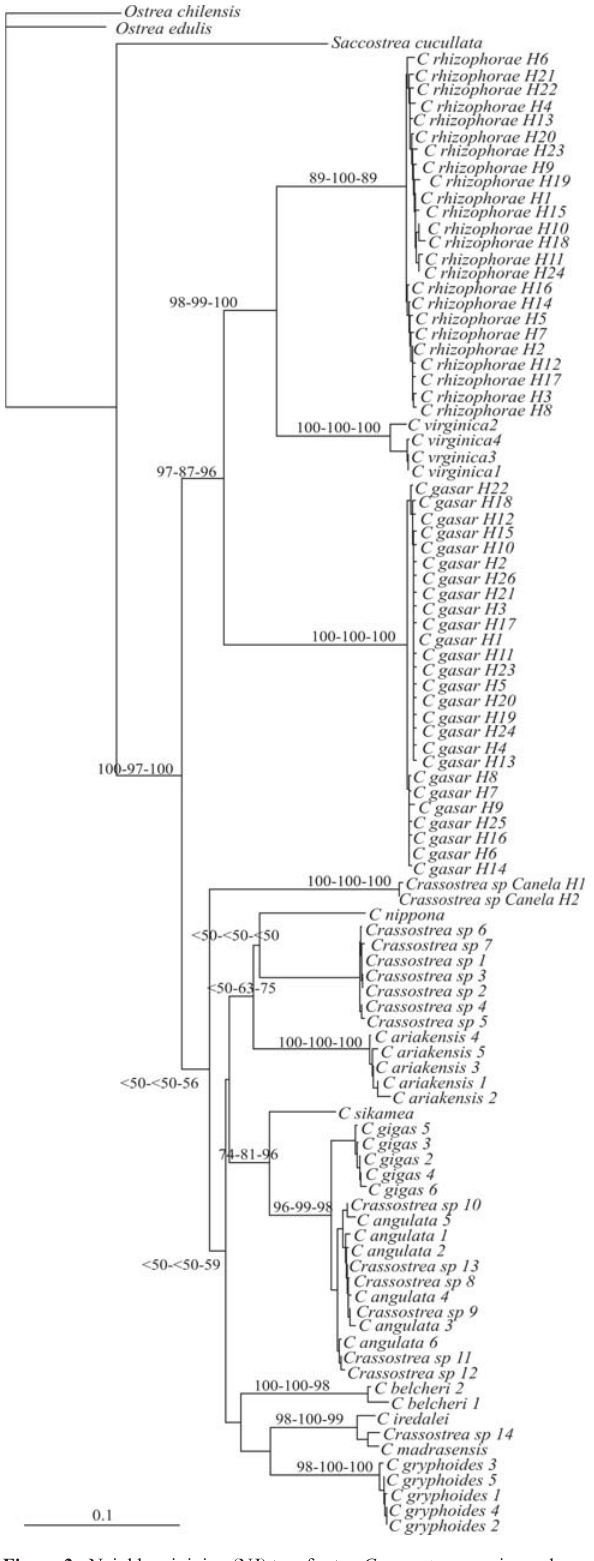
Figure 3 - Neighbor-joining (NJ) tree for ten Crassostrea species and one Saccostrea cucullata based on COI . Ostrea chilensis and Ostrea edulis were used as outgroups. Numbers above the branches are the bootstrap support values for NJ, Maximum Parsimony and Maximum Likelihood analyses,